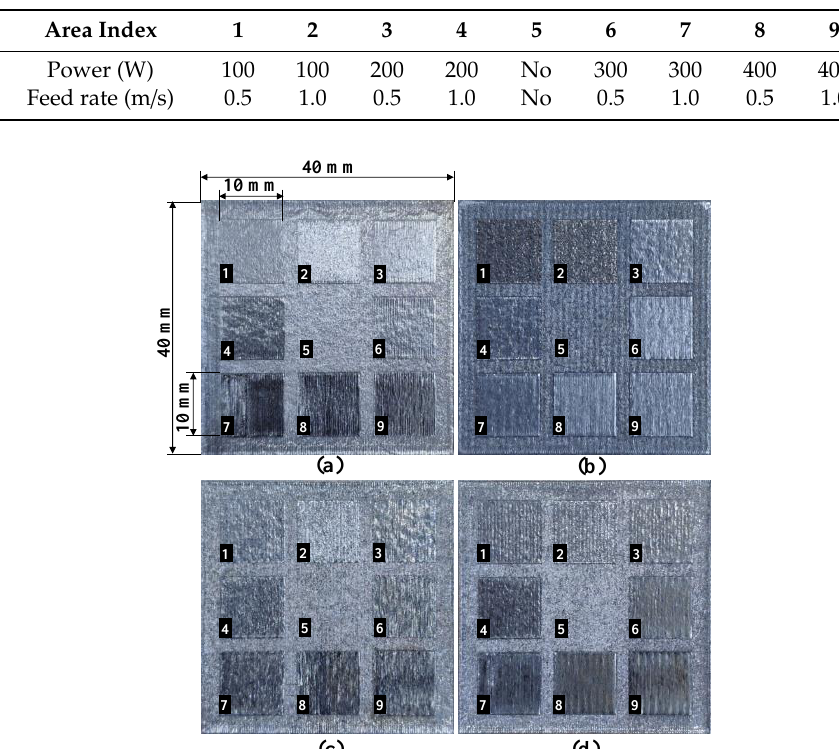
Figure 3. Initial and polished surfaces: ( a ) Ti6Al4V, ( b ) AlSi10Mg, ( c ) 316L and ( d ) IN718.